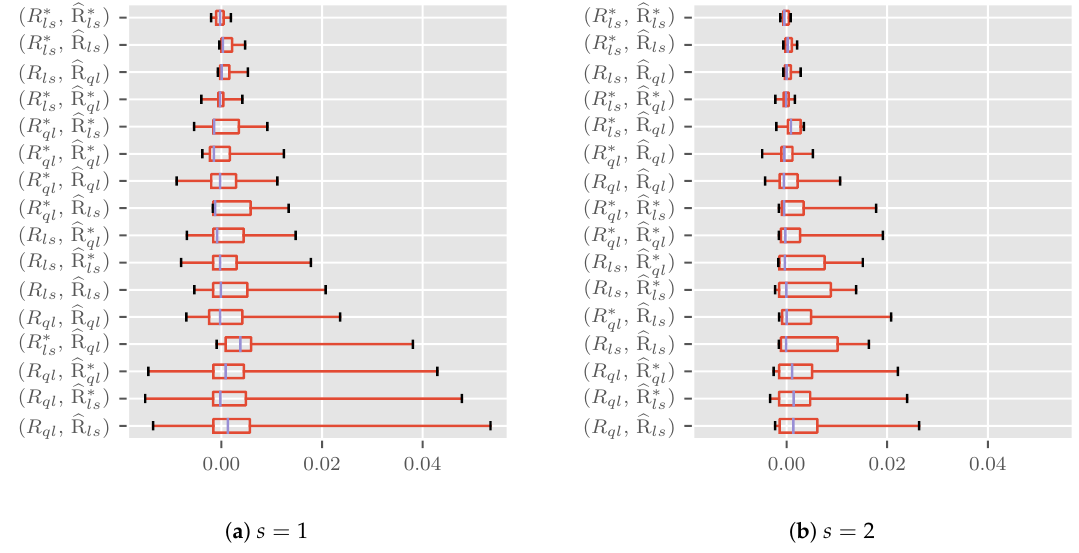
Figure 3. Box plots of size error at 5% critical values over parameterizations ( VNJ , TA and BZ ) and data generating processes (generalized log-normal and over-dispersed Poisson). Results for s = 1 shown in ( a ) and for s = 2 in ( b ). Medians indicated by blue lines inside the boxes. The boxes show the interquartile range. Whiskers represent the full